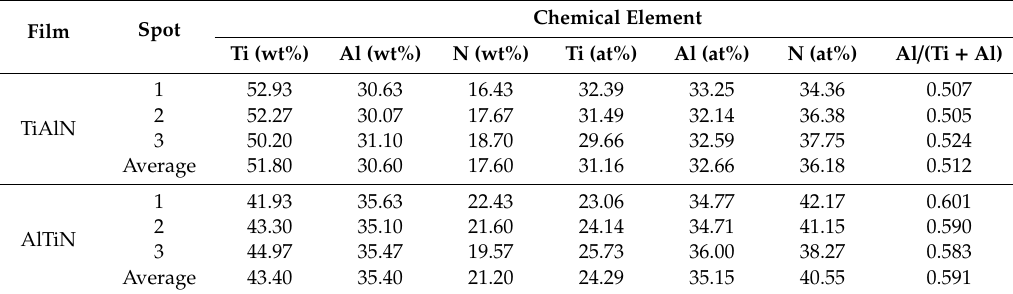
Figure 2. Surface of the PVD coatings: ( a ) TiAlN; ( b ) AlTiN, SEM. Table 1. Results of SEM-EDS surface chemical composition spot analysis.